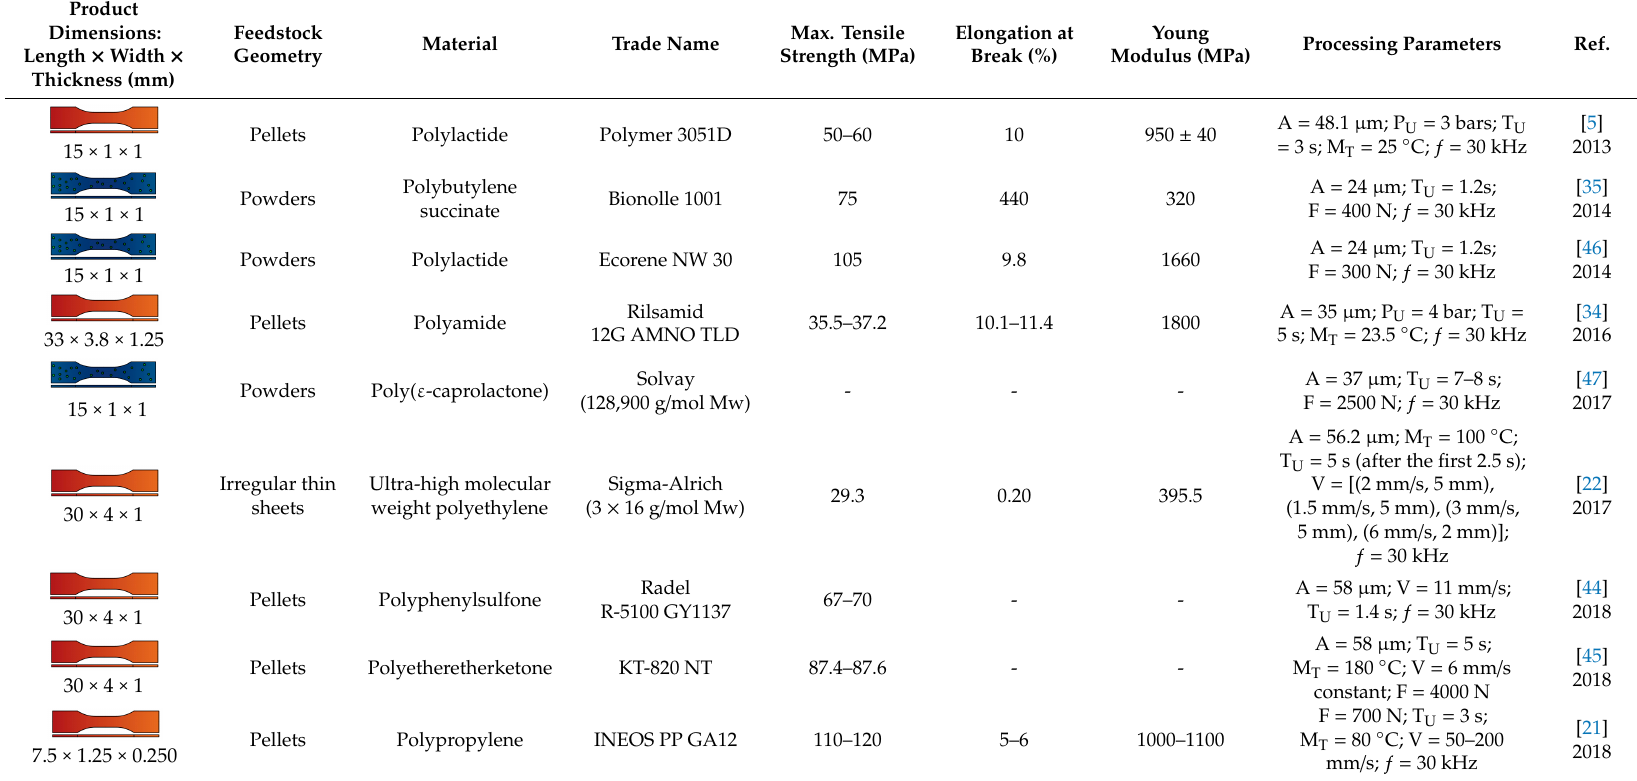
Table 2. Examples of biomaterials processed by UIM.